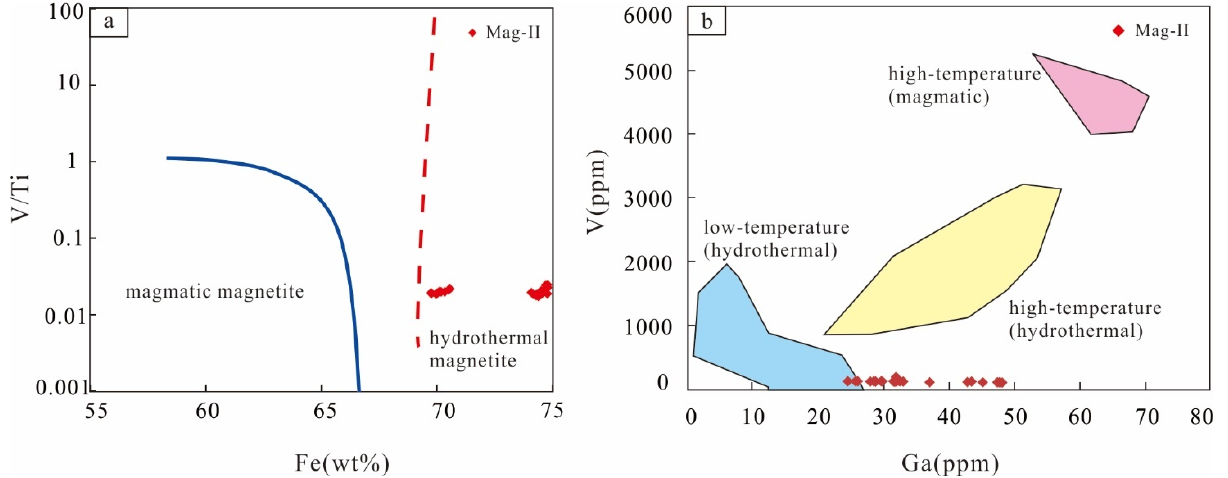
Figure 8. ( a ) Fe (wt %) vs. V/Ti discrimination diagram for magnetite proposed by Wen et al. [89]; ( b ) V vs. Ga content in magnetite and data for high-temperature magmatic, high–temperature hydrothermal and low-temperature hydrothermal magnetite collected by Salazar et al. [90].